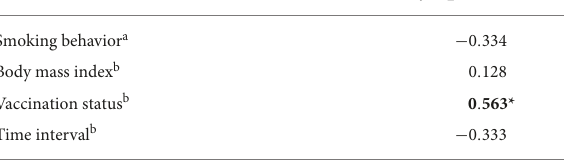
TABLE 4 Correlations between smoking behavior, body-mass-index, vaccination status, time interval (between survey participation and infection), and symptom